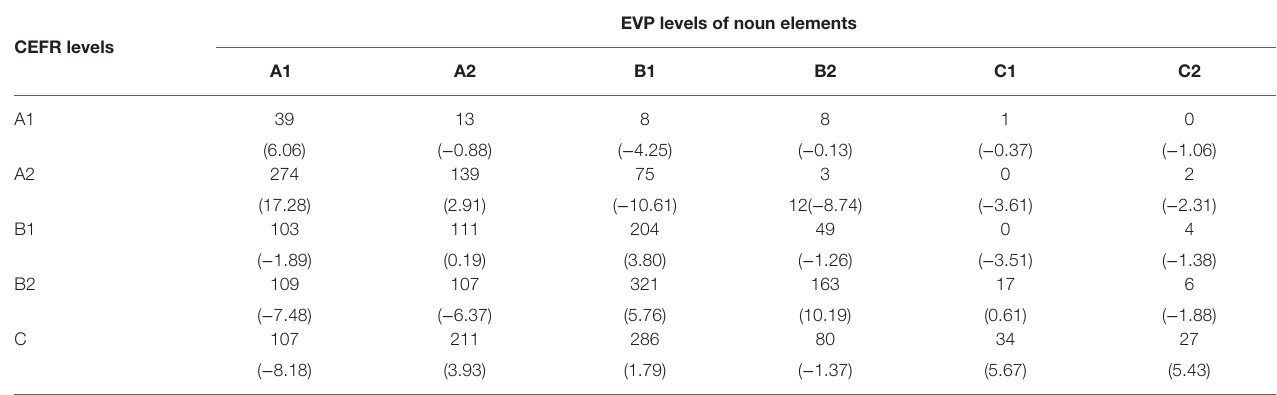
TABLE 5 | Crosstabulation of proficiency level and difficulty level of noun elements. CEFR levels